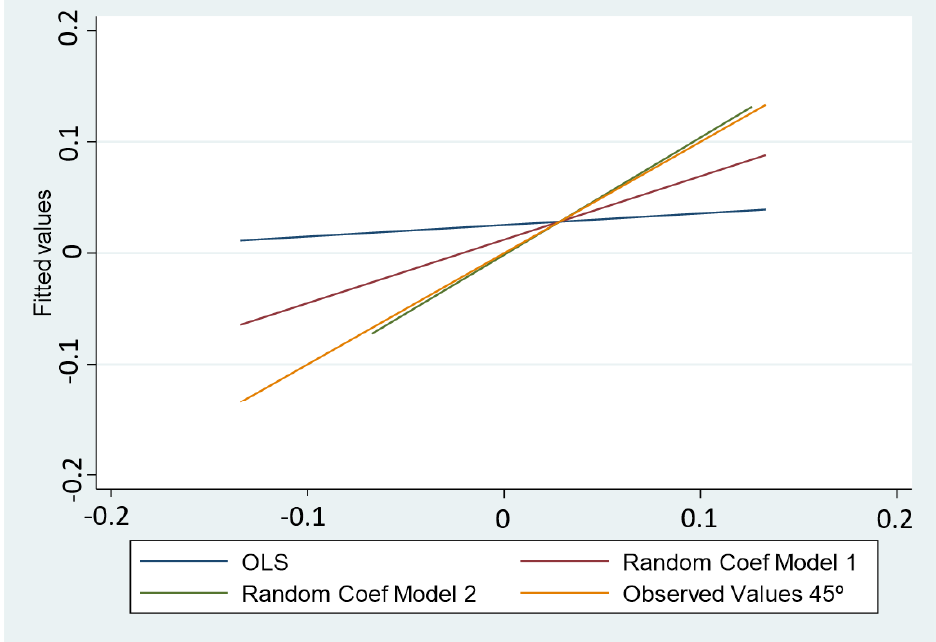
Figure 3. Values predicted by OLS and random coefficients vs. observed values of economic perfor- mance.